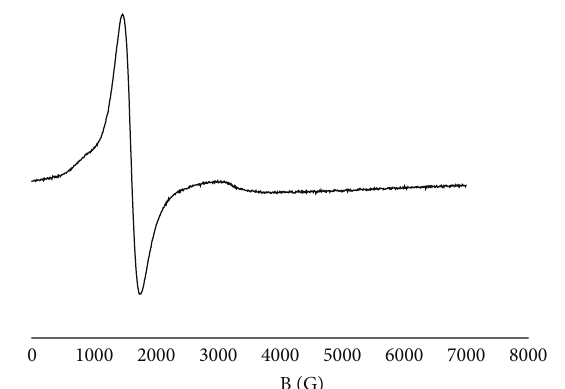
Figure 11: EPR spectrum for [Cu 2 Co( S,S (+)cpse) 3 (H 2 O) 3 ] ⋅ 4H 2 O ( 1